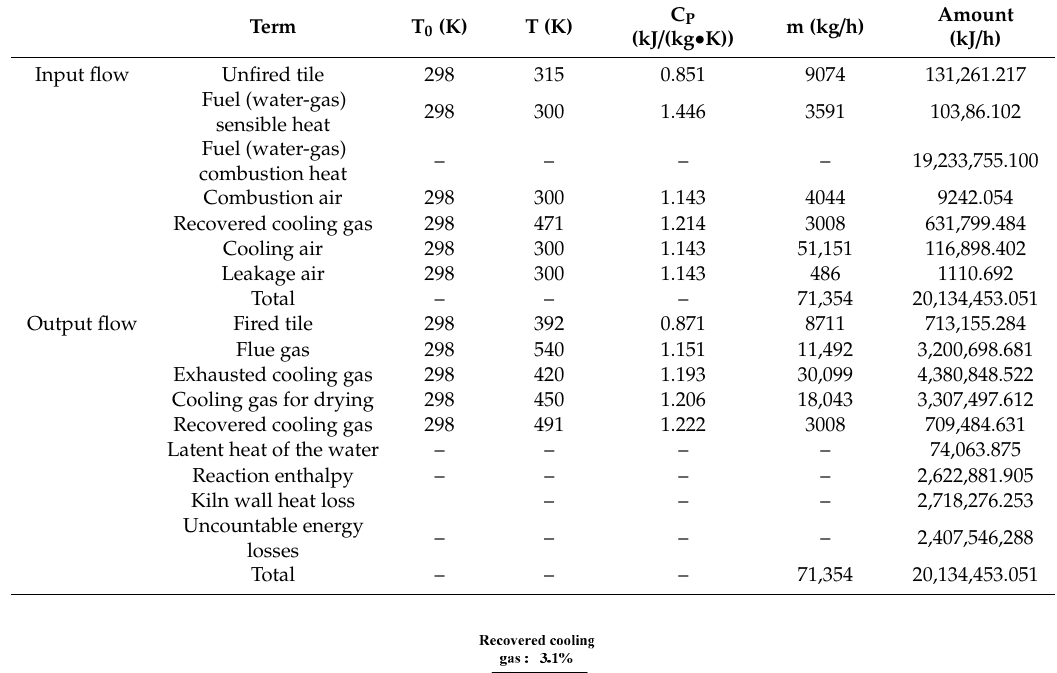
Table 9. Energy balance of the roller kiln.